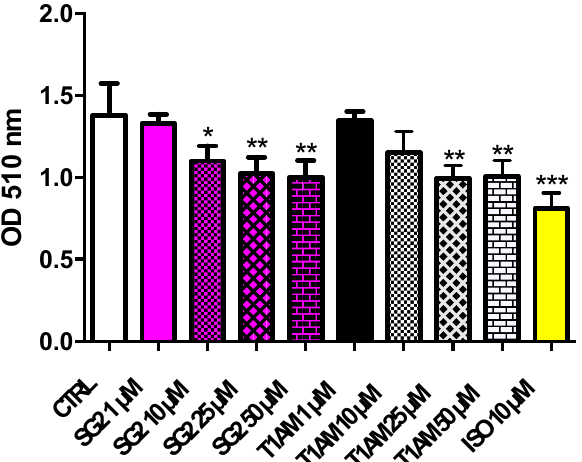
Figure 5. Effects of T1AM and SG-2 on lipid accumulation in fully differentiated 3T3-L1 cells. Mature adipocytes were treated for 24 h with T1AM or SG-2 (1, 10, 25, 50 µM). 10 µM isoproterenol (ISO) was used as positive control. Oil red O stained intercellular oil droplets were eluted with isopropanol and quantified by spectrophotometry analysis at 510 nm. Values represent the mean ± SEM of 4–8 experiments. The groups were compared using the One-Way ANOVA followed by Tukey’s range test. * p < 0.05; ** p < 0.01; *** p < 0.005.